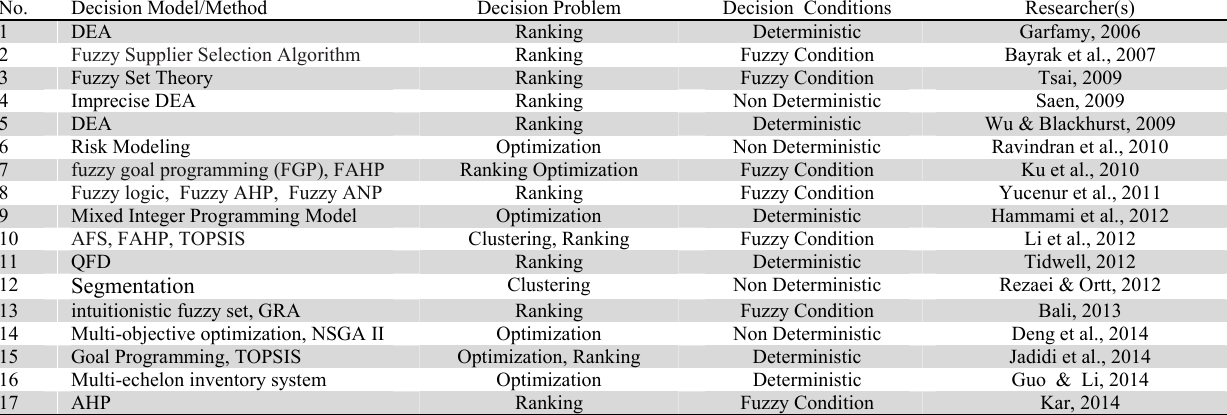
A summary of the previous studies on maintenance